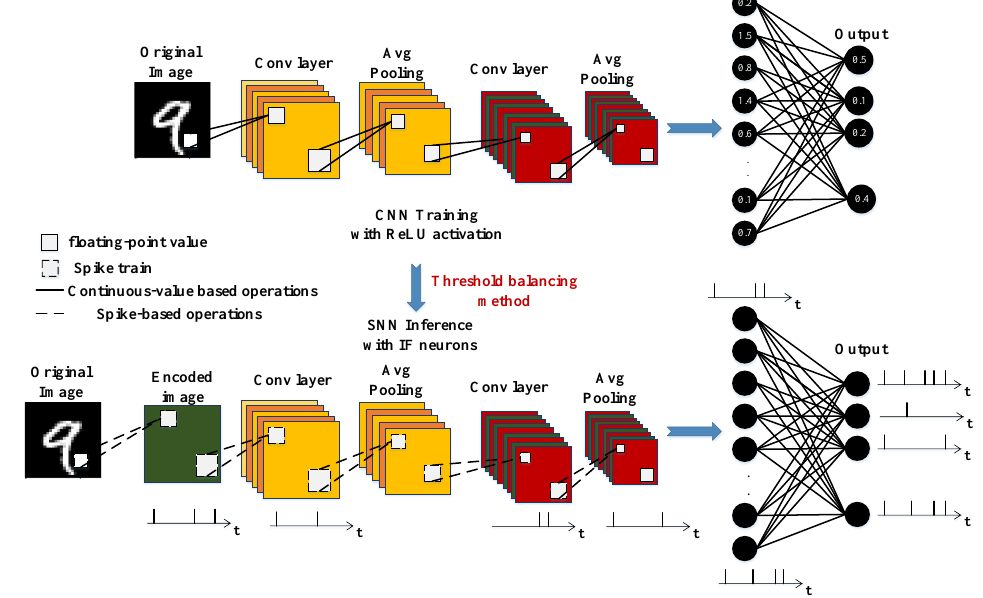
Figure 2. The CNN–SNN conversion